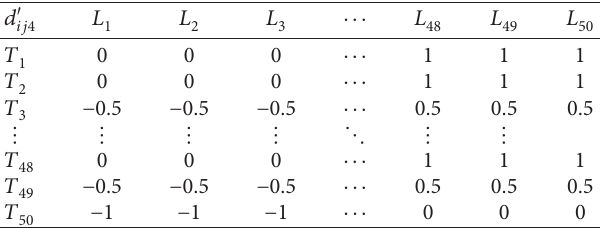
� [ v b ] for tenants’ ij 4 50 × 50 4